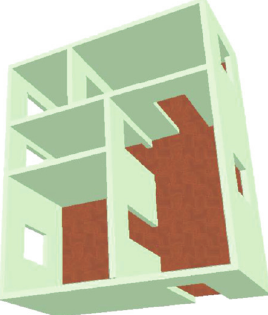
Figure 16: Three-dimensional model of a generated floor